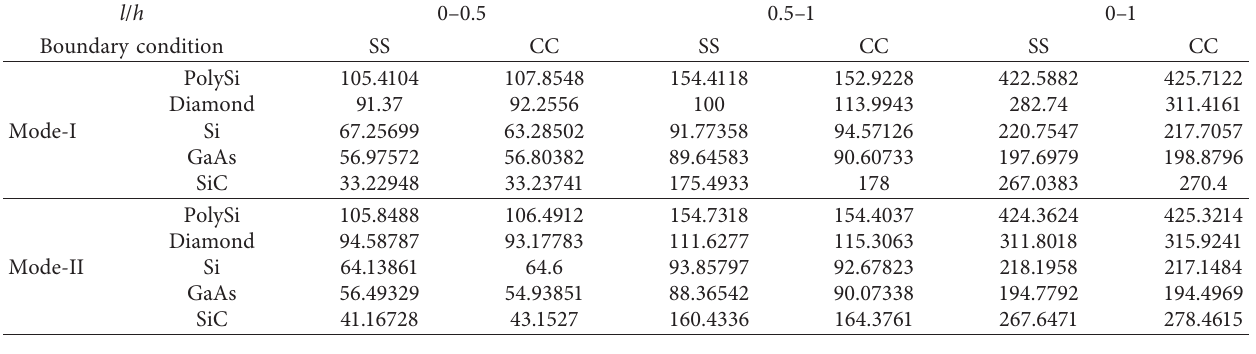
TED with size effect ( l/h